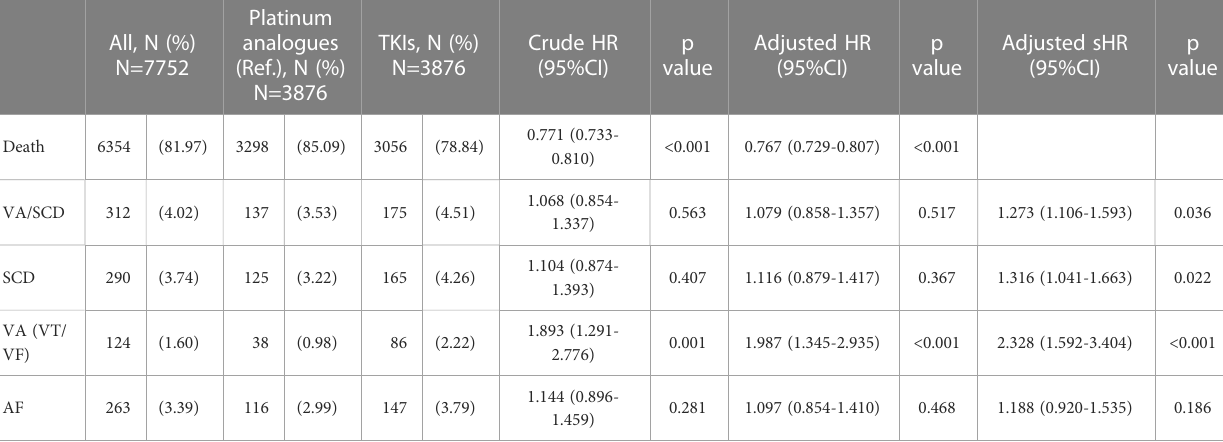
TABLE 2 The crude and adjusted hazard ratio (HR) and subdistribution hazard ratio (sHR) of patients with non-small cell lung cancer (NSCLC) treated with either Platinum analogues or